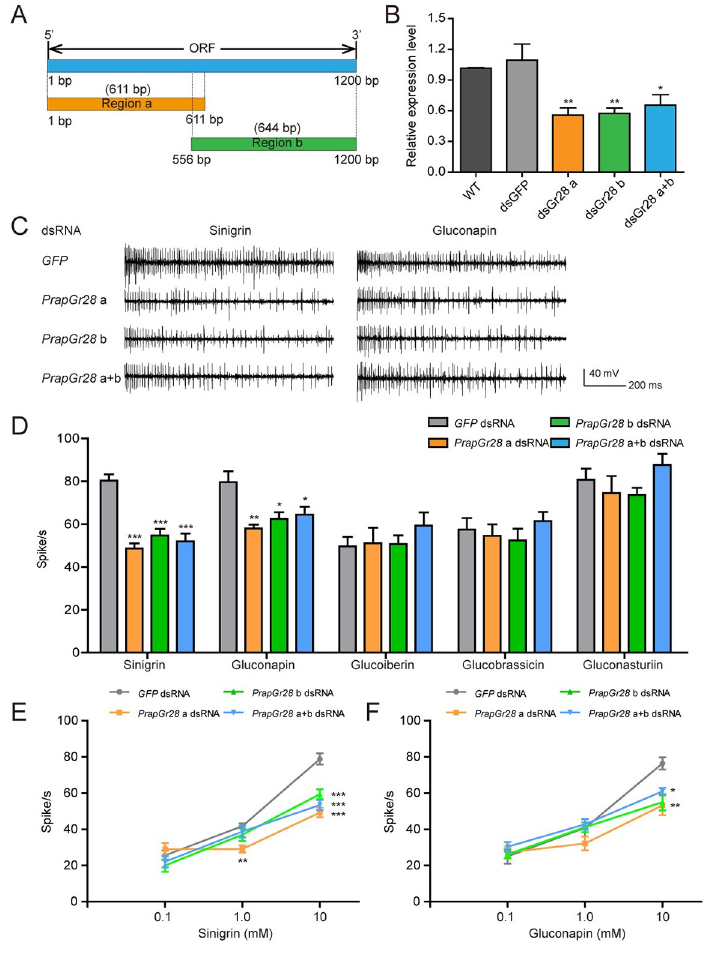
Fig 8. RNA interference of PrapGr28 suppresses the response to glucosinolates in female butterflies. ( A ) Schematic of PrapGr28 and the regions used for dsRNA synthesis. Region a and b, named PrapGr28 a and PrapGr28 b, respectively, are portions of the coding region of PrapGr28 used for preparation of dsRNA. ( B ) Relative expression levels of PrapGr28 in dsRNA-injected adult butterflies. n = 4–5. WT, wild type without injection; dsGFP, GFP dsRNA; dsGr28 a, PrapGr28 a dsRNA; dsGr28 b, PrapGr28 b dsRNA; dsGr28 a+b, PrapGr28 a+b dsRNA. ( C ) Representative responses and ( D ) smaller amplitude spike frequencies elicited by glucosinolates in the medial sensilla of the fifth prothoracic tarsi. Sinigrin, n = 10–13; gluconapin, n = 9–14; glucoiberin, n = 7–13; glucobrassicin, n = 6–12; gluconasturtiin, n = 6–14. All tested glucosinolates were at 10 mM. ( E , F ) Dose-response curves from medial sensilla on the prothoracic tarsi of female butterflies to gradient concentration of sinigrin ( n = 5–9) and gluconapin ( n = 5–9), respectively. Data are presented as mean ± SEM. One-way ANOVA with Tukey HSD test was used. � P < 0.05, �� P < 0.01, ��� P < 0.001, compared with the